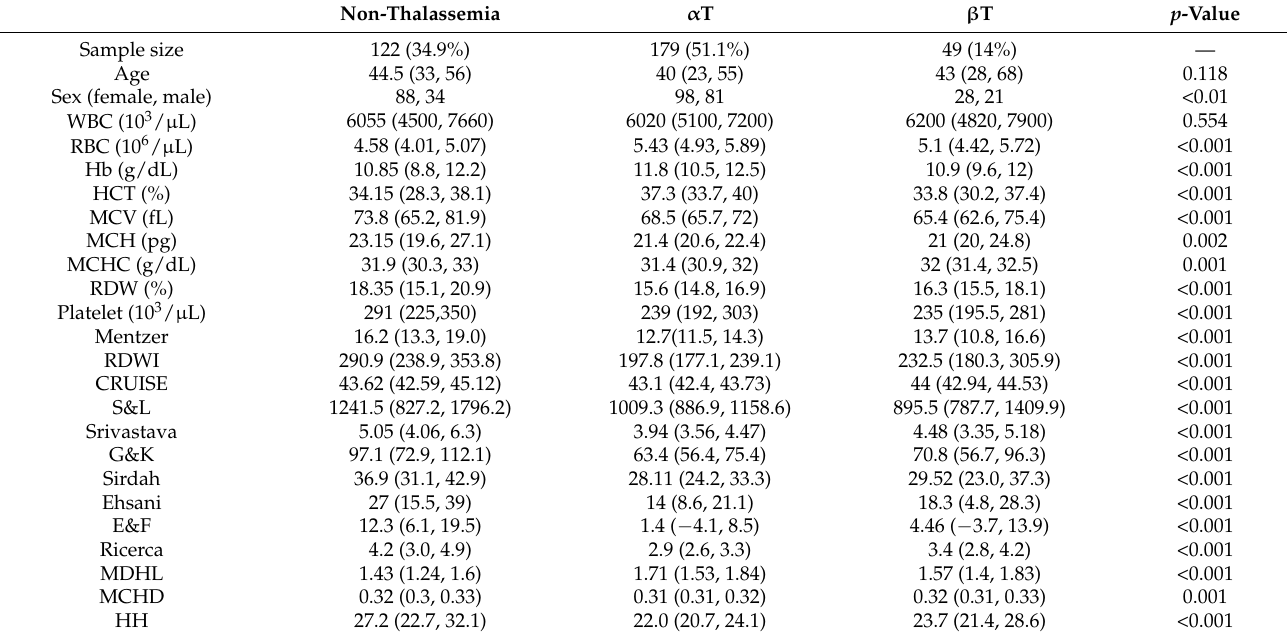
Table 1. Demographic characteristics of 350 patients.